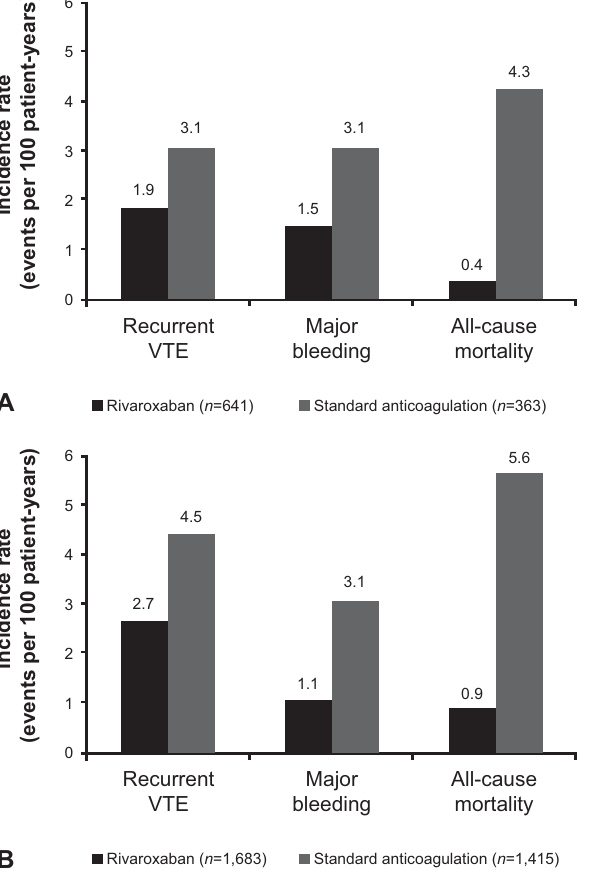
Fig.2 Unadjustedtreatment-emergentoutcomesinpatients with( A ) IDDVT or ( B ) PDVT in the safety analysis set treated with rivaroxaban or standard anticoagulation. Abbreviations: IDDVT, isolated distal deep-vein thrombosis; PDVT, proximal deep-vein thrombosis; VTE, venous